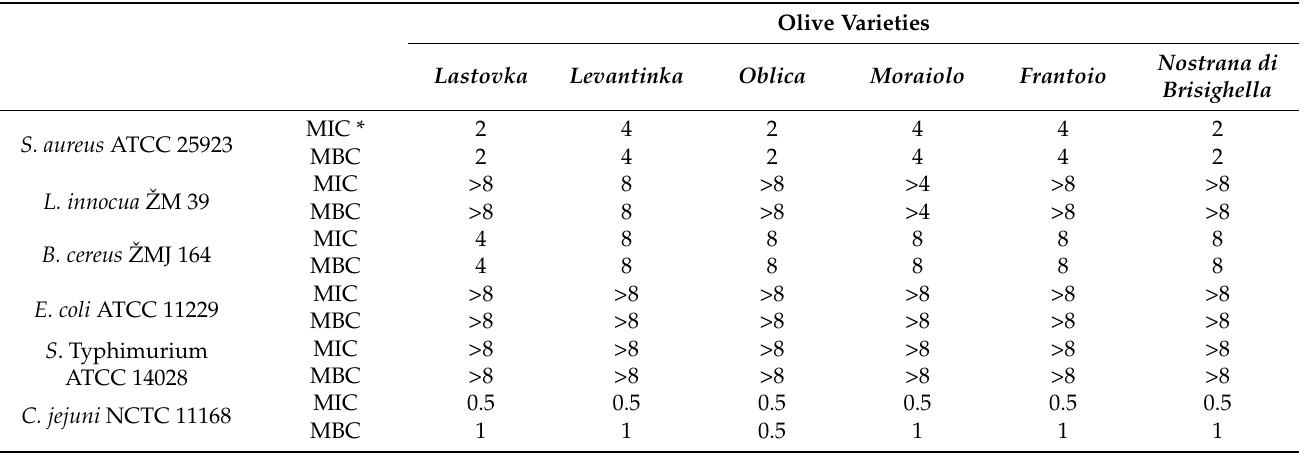
Table 2. Antimicrobial activity of olive leaf extracts expressed as minimal inhibitory concentration (MIC) and minimal bactericidal concentration (MBC) (in mg of dry extract/mL). Olive Varieties Nostrana di Lastovka Levantinka Oblica Moraiolo Frantoio Brisighella MIC * 2 4 2 4 4 2 S. aureus ATCC 25923 2 4